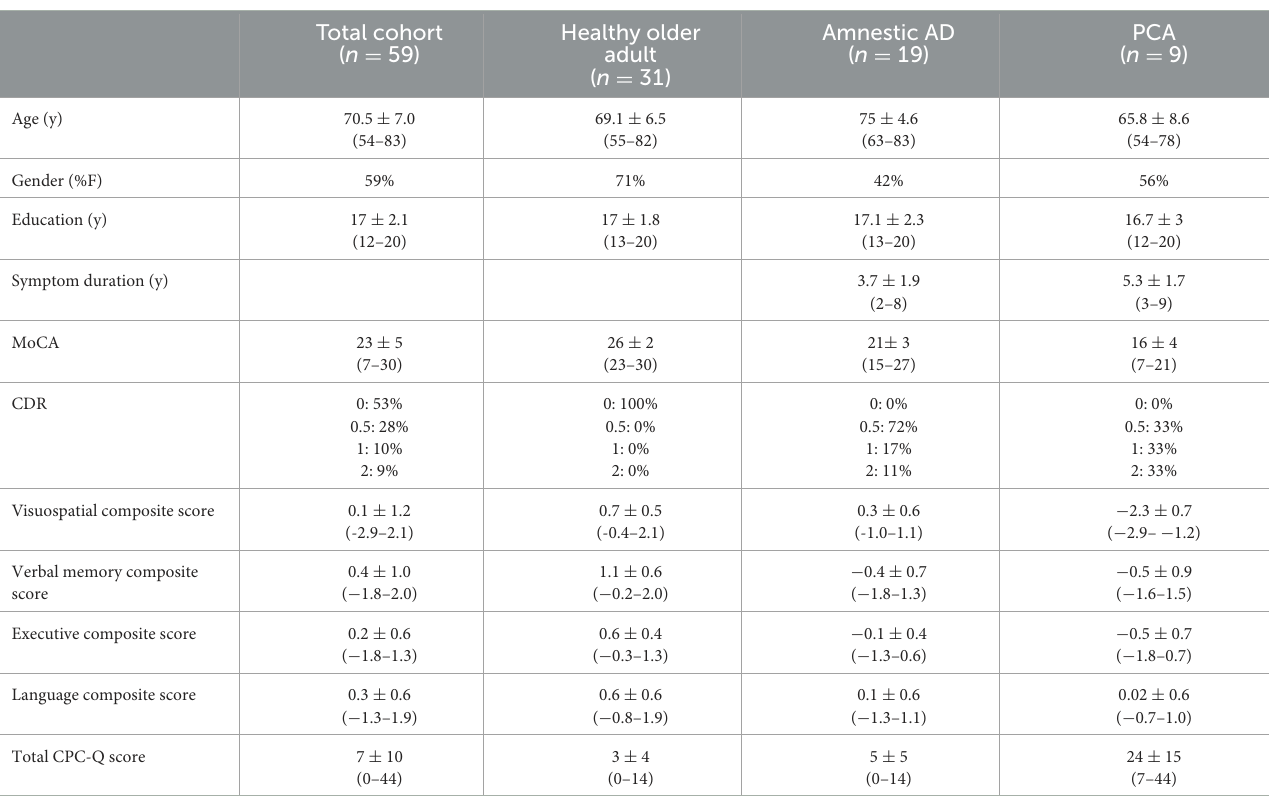
TABLE 1 Demographic and clinical